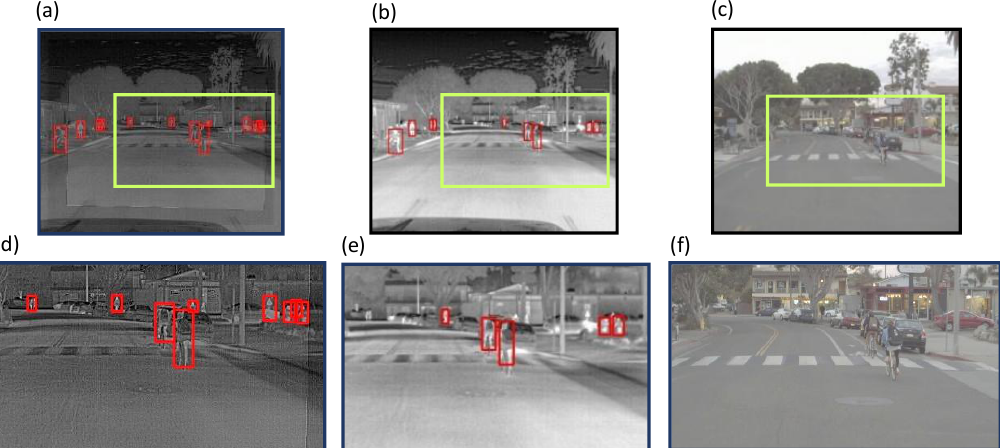
Figure 12. Image FLIR_08807: an example of pedestrian classification based on the correct detection of unmarked ground truth annotation in a day image by the network ( a , d ) vs. unmarked pedestrians in GT annotation ( b , e ). A subsection marked in network classification of the RXD Anomaly Fusion image ( a ), GT image ( b ), and original RGB image ( c ), with light green boxes that are zoomed in to the region of interest, shown in images ( d , e , f ), respectively. The annotated ground truth area ratio was 111%. Out of two images that scored less than 50% IoU, the first was partially classified by the network, while the second was cor- rectly classified by the network as a missing annotation on ground truth.